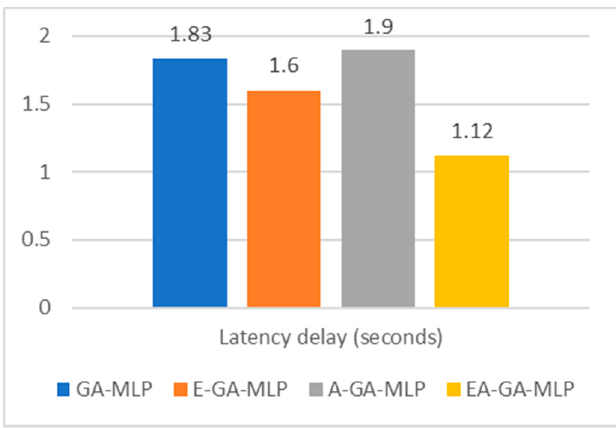
Figure 6. Comparative analysis of latency of presented algorithm EAGA with its subcomponents.